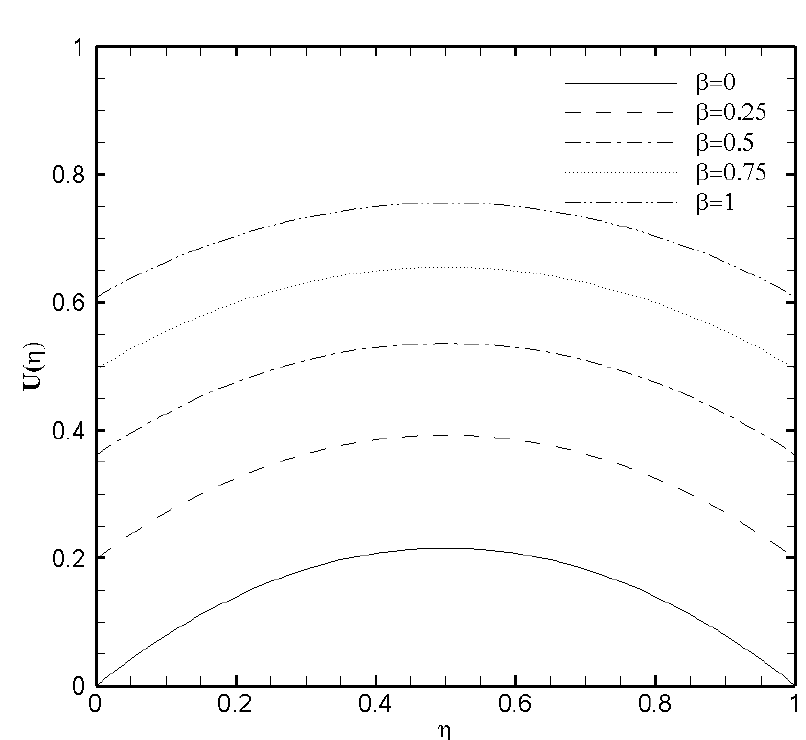
Figure 4. Velocity profile U ( η ) for several values of slip parameter β when ζ = P = κ = 1 and Ha =